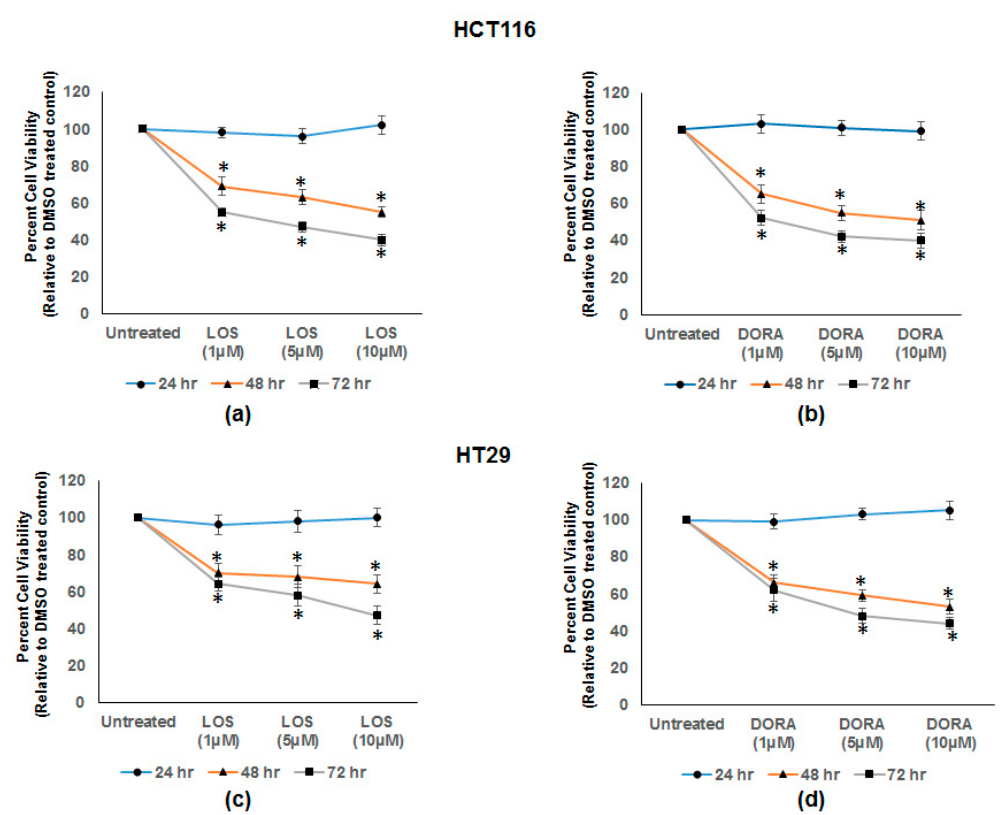
Figure 5. Cell growth inhibition of human CRC HT-29 and HCT 116 cell lines by losmapimod and doramapimod. HCT-116 and HT-29 CRC cells were treated with DMSO (untreated) or with di ff erent doses of losmapimod (LOS) and doramapimod (DORA) for 24, 48, and 72 h. Determination of viable / live cells was carried out by MTT assay as described in Section 2. ( a , b ) show the dose dependent inhibition of cell growth at 48 and 72 h by losmapimod and doramapimod in HCT-116 cells. Similarly, ( c , d ) show the dose dependent inhibition in HT-29 cells. The results are shown as mean ± SEM ( n = 6); * p -value < 0.005. The dose is on the x-axis, and the viability of cells on